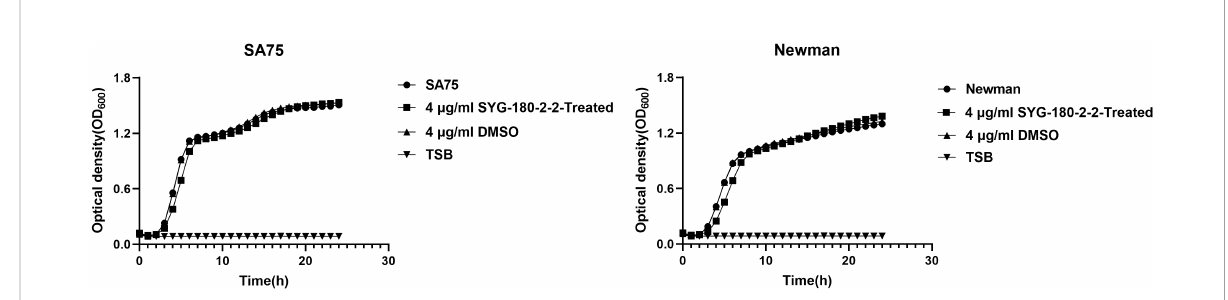
FIGURE 1 Growth curves of SA75 and Newman strains cultured with 4 m g/mL or without SYG-180-2-2. TSB was used as a blank control.